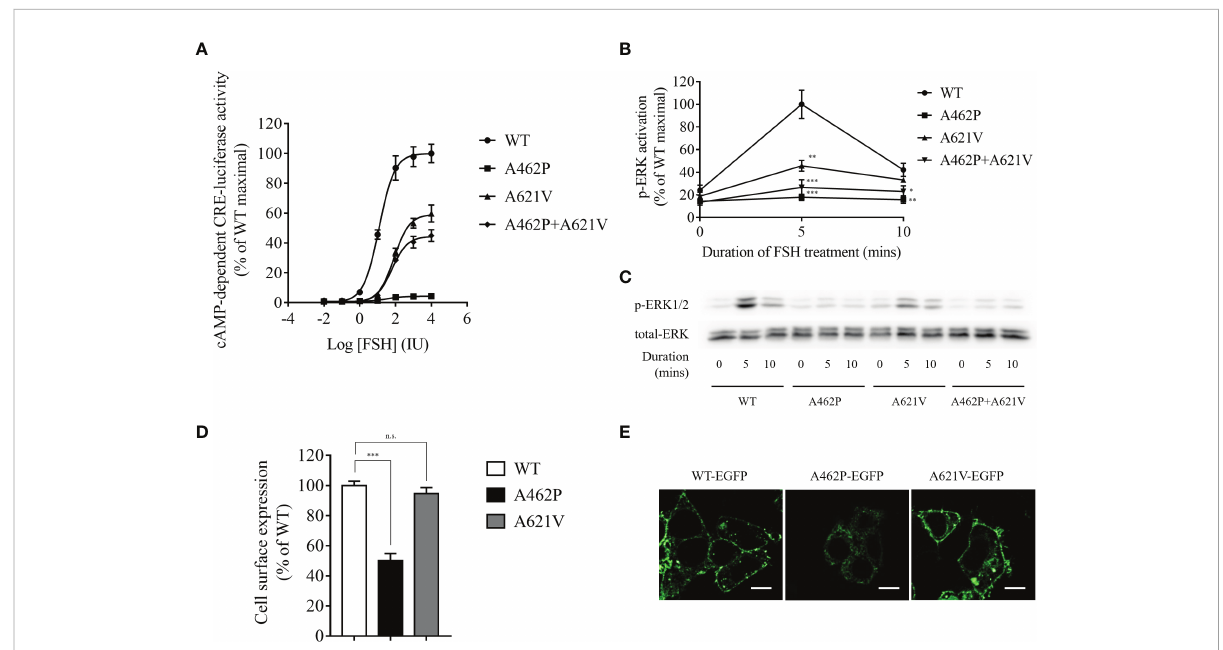
FIGURE 2 Functional evaluation of variants. (A) Dose-dependent curve of cAMP-dependent CRE-luciferase activity for FSHR variants upon FSH treatment. Variant transfected HEK293 cells were incubated with various FSH concentrations for 4 h. Data are expressed as percentage of WT maximal stimulation and represent the mean ± SEM of six independent experiments. (B) Time course of FSH-stimulated phosphorylation of ERK1/2 in cells expressing variants. Data are expressed as percentage of WT maximal stimulation and represent the mean ± SEM of three independent experiments. * P < 0.05, ** P < 0.01, *** P < 0.001 vs. WT FSHR . (C) Representative images of immunoblots using antibody against phosphorylated ERK1/2. Transfected cells were incubated with 500 IU FSH for the indicated time. (D) Bar plots showing quantitative fl uorescence microscopy analysis of cell surface expression for all variants. Data are expressed as percentage of WT FSHR and represent the mean ± SEM of six independent experiments. *** P < 0.001 vs. WT FSHR , n.s. not signi fi cant. (E) Representative fl uorescence microscopy images of the receptor cellular localization. Bar = 20 µm.